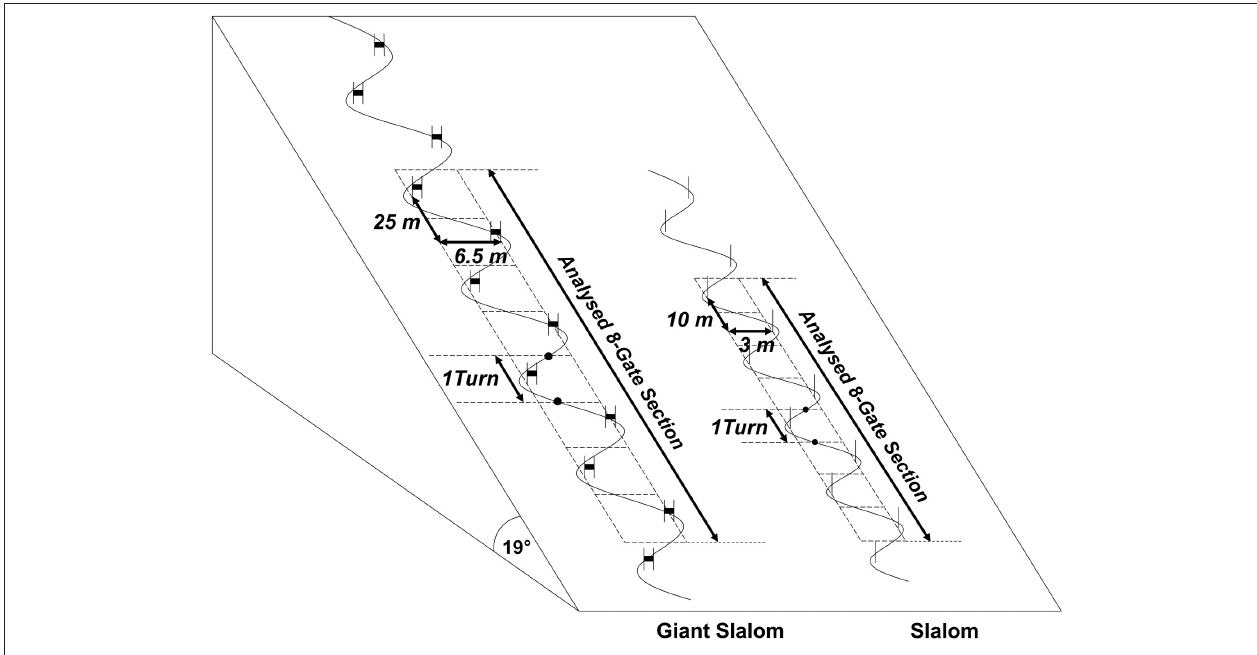
FIGURE 1 | Schematic overview of the experimental on-hill